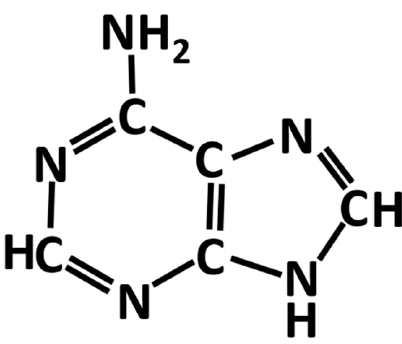
Figure 1. Chemical structure of an adenine molecule.